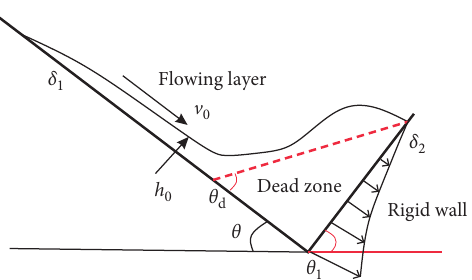
Figure 1: Division of the dead zone and the flowing layer